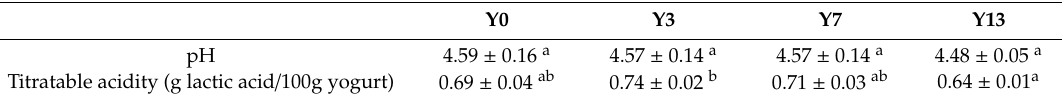
Table 1. Measurements of pH and titratable acidity of yogurt with cascara extract (Y0), yogurt with cascara extract and 3% inulin (Y3), yogurt with cascara extract and 7% inulin (Y7), and yogurt with cascara extract and 13% inulin